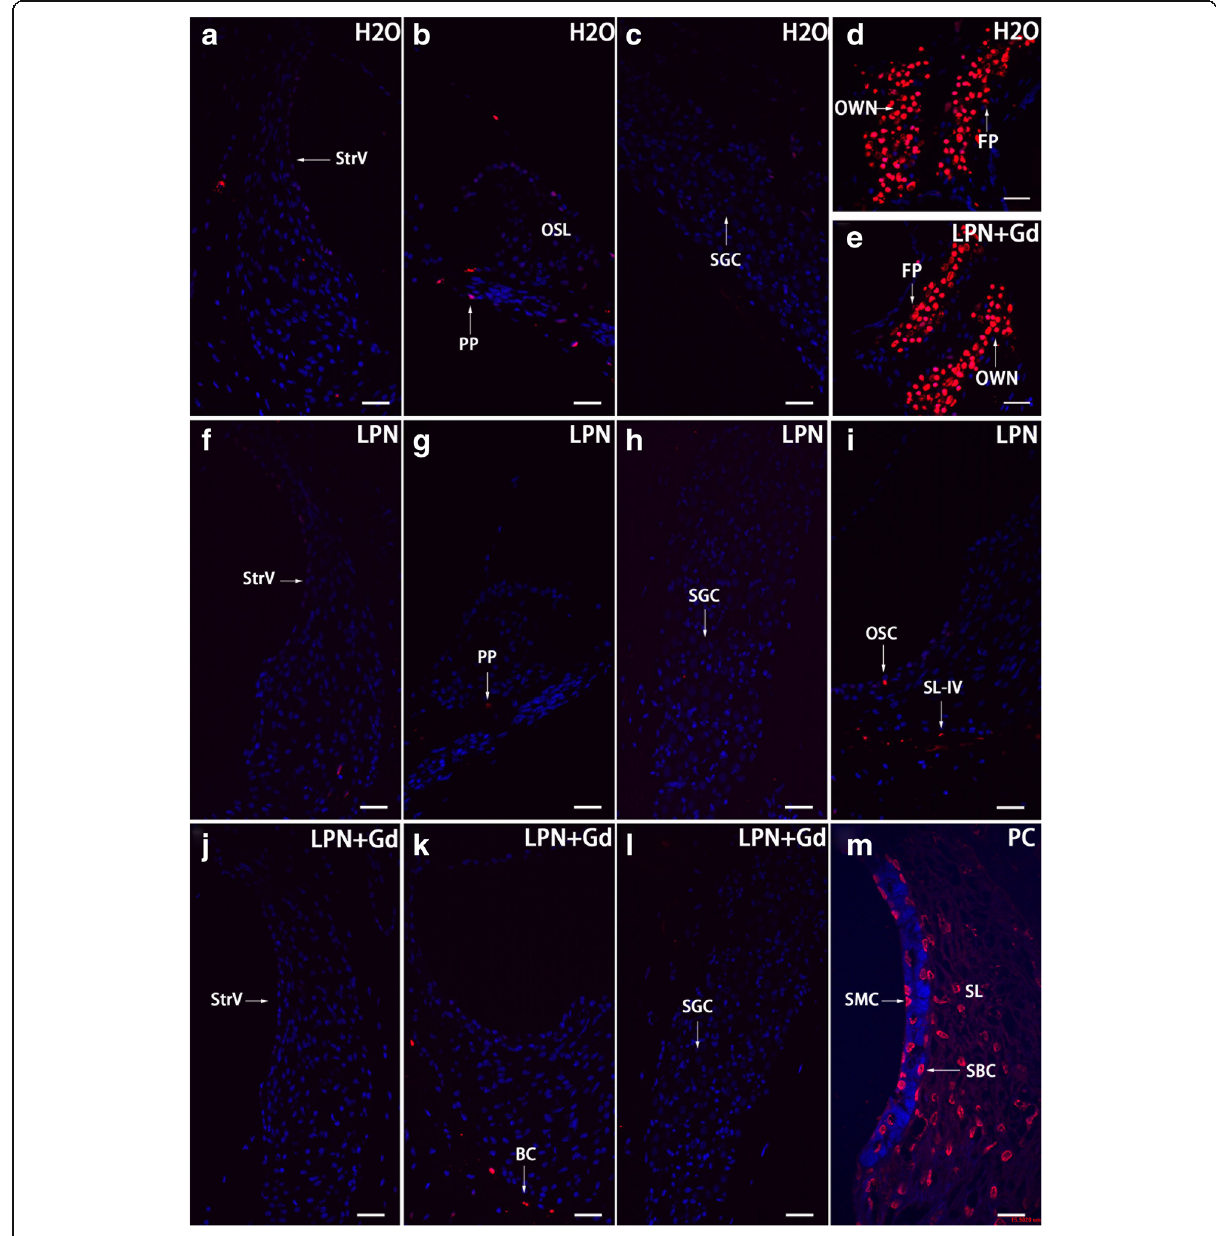
Fig. 13 Apoptosis in the rat cochlea exposed to liposome nanocarriers demonstrated using TUNEL staining confocal microscopy. Apoptotic cells were sparsely detected in the cochlear cells of rats in groups of negative control ( H2O ) ( a – c ), empty liposome nanocarriers ( LPN ) ( f – i ), and Gd-DOTA-containing LPN ( LPN+Gd ) ( j – l ). There were abundant apoptotic cells in the footplate of the stapes ( FP ) and oval window niche ( OWN ) of both groups ( d , e ). In a positive control (PC), abundant TUNEL staining was detected in the spiral ligament fibrocytes ( SL ), stria basal cells ( SBC ), and stria margina cells ( SMC ). PP periphery process of the spiral ganglion cell ( SGC ), OC osteocyte, OSC outer sulcus cell, SL-IV type IV of spiral ligament fibrocytes, SLim spiral limbus, StrV stria vascularis. Scale bar a – l =32 μ m, m =16 μ